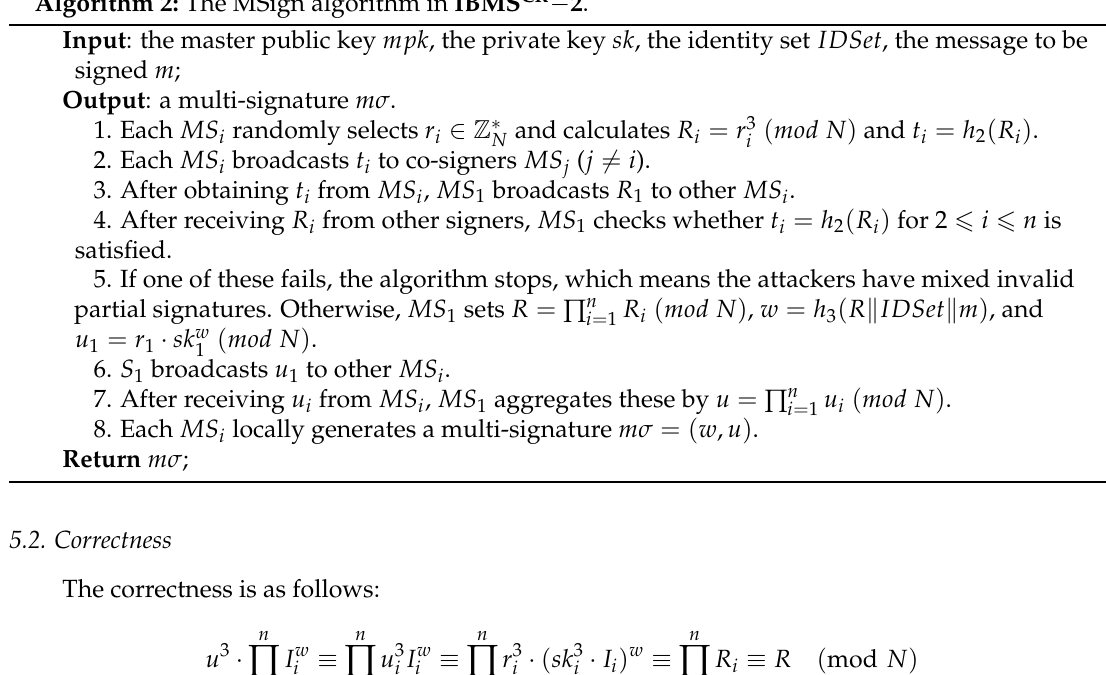
Algorithm 2: The MSign algorithm in IBMS CR − 2